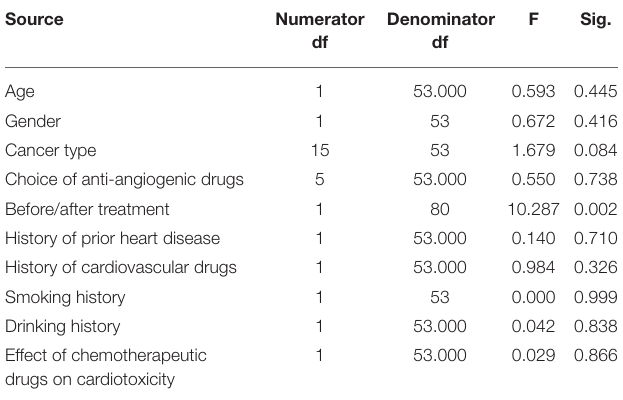
TABLE 6 | Type III test of fixed effects of